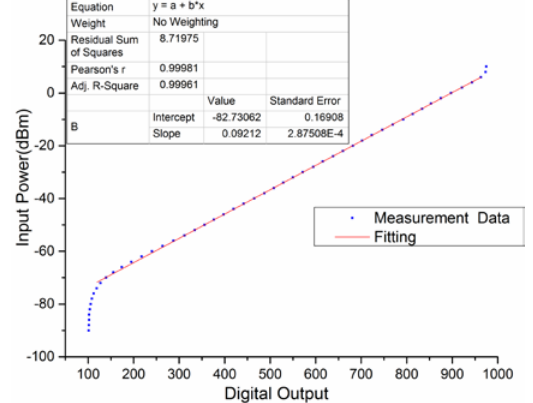
Figure 1. Calibrated relationship between the input power and digital output from 10-bit A/D converter.